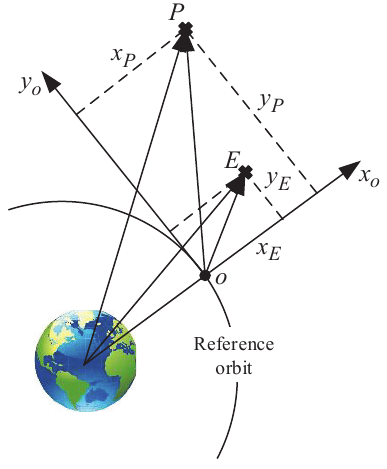
Figure 1. The location of the pursuer and the